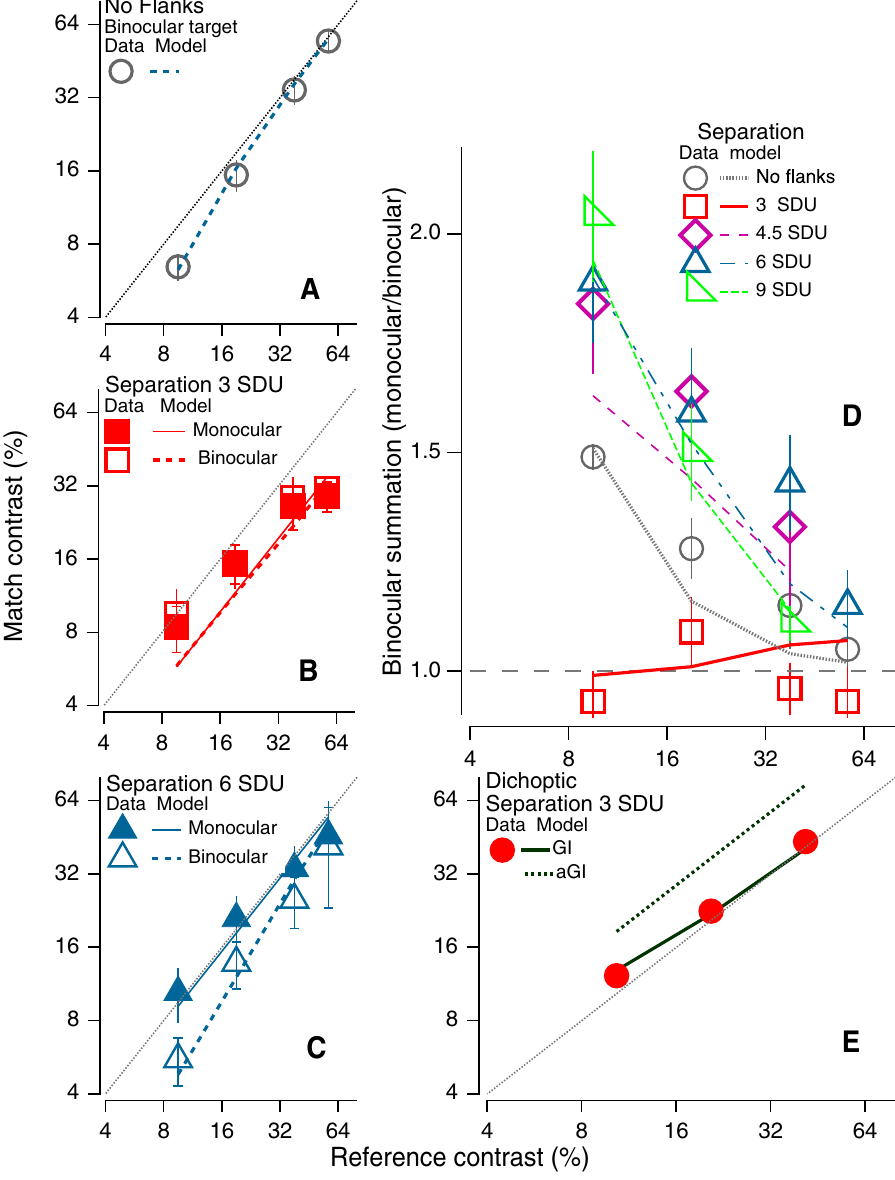
Figure 4. Binocular and monocular matching contrast as a function of reference contrast for a monocular isolated Gabor test patch, as a function of the contrast of an isolated monocular reference ( A ), and for flanked Gabor test patch, presented either monocularly or binocularly ( B and C panels). ( D ) Binocular summation (monocular/binocular contrast ratio) as a function of reference contrast. The flank contrast was fixed at 9.5 × target detection threshold, and the flank-target separation varied, as shown by the different symbols. The lines in panels ( A – D ) are the fits of GI model. ( E ) Dichoptic matching (target in one eye, abutting flankers in the other). Data are average data for 3 observers. The model predictions are shown by the thick dotted line (aGI) and the thick solid line